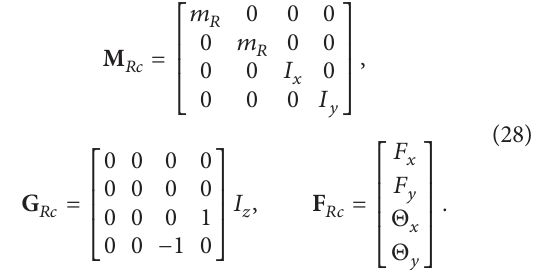
Figure 10: Effect of the number of rollers on radial force-displace- ment relationship.